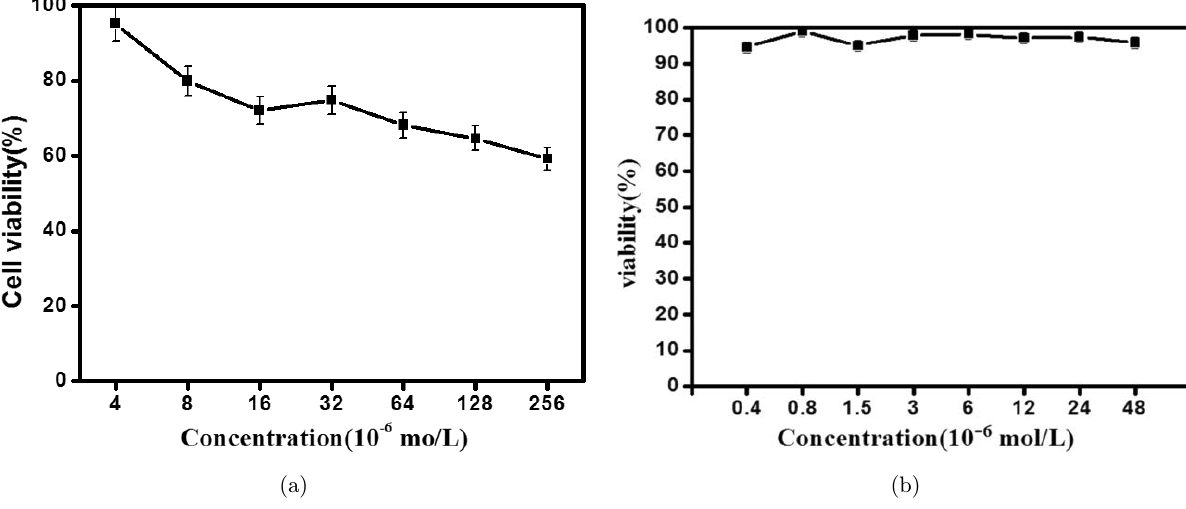
Fig. 3. The toxicity of UBI29-41-ICG02 to L02 cells and the antibacterial studies to S. aureus . (a) The toxicity to L02 cells. With the concentration of UBI29-41 increased, the toxicity increases too. When the concentration is below 8 (cid:2) 10 (cid:1) 6 mol/L, the cell viability is above 80% and there is no obvious toxicity. (b) The viability of S. aureus in di®erent concentration of UBI29-41. From 0 : 4 (cid:2) 10 (cid:1) 6 mol/L to the maximum concentration of 48 (cid:2) 10 (cid:1) 6 mol/L , there is no inhibition to the growth of the S.